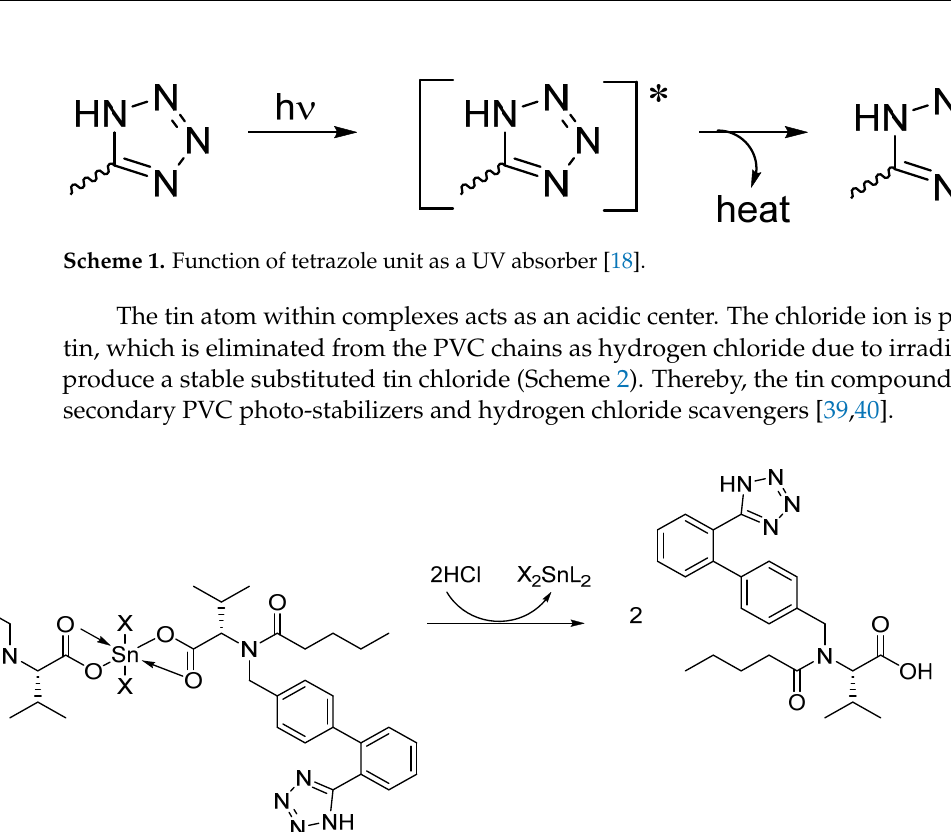
11 Figure 10. Energy-dispersive X-ray graph of PVC films. 3.6. Suggested Mechanisms of Organotin Complexes Efficiency The addition of tin(IV) complexes as additives significantly reduced the photodegra- dation of PVC sheets. Among the two tested tin(IV) complexes, SnL 2 Cl 2 resulted in higher photostability for the PVC film than Me